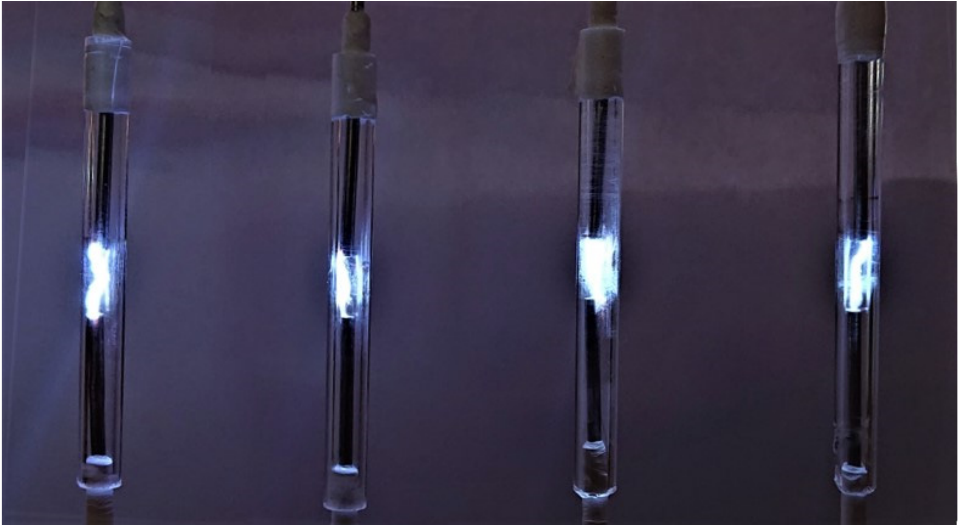
Figure 15. The four RCG reactors working in parallel.